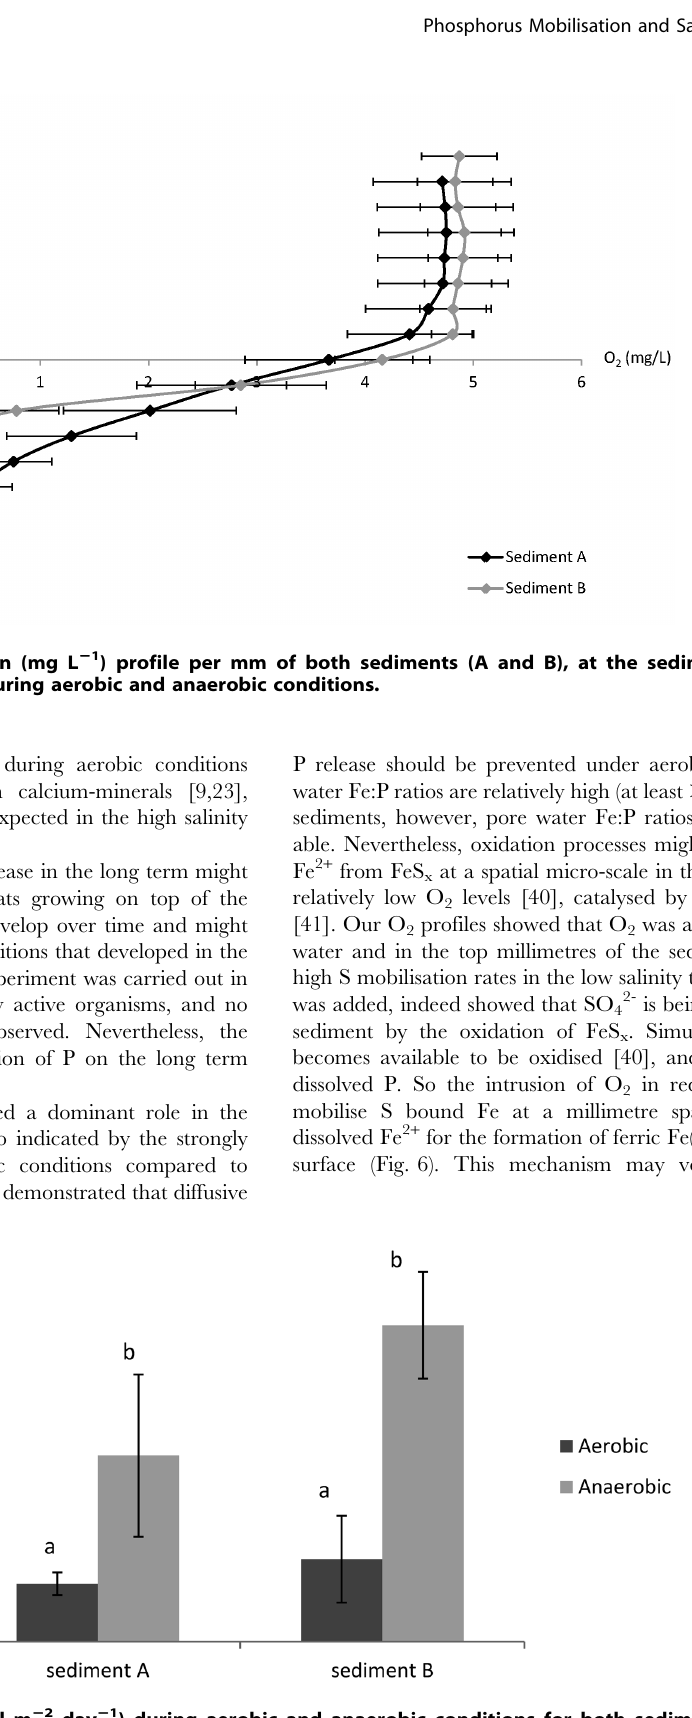
Figure 5. P mobilisation rates ( m mol m 2 2 day 2 1 ) during aerobic and anaerobic conditions for both sediment cores (A and B). Significant differences between treatments are indicated with different letters.